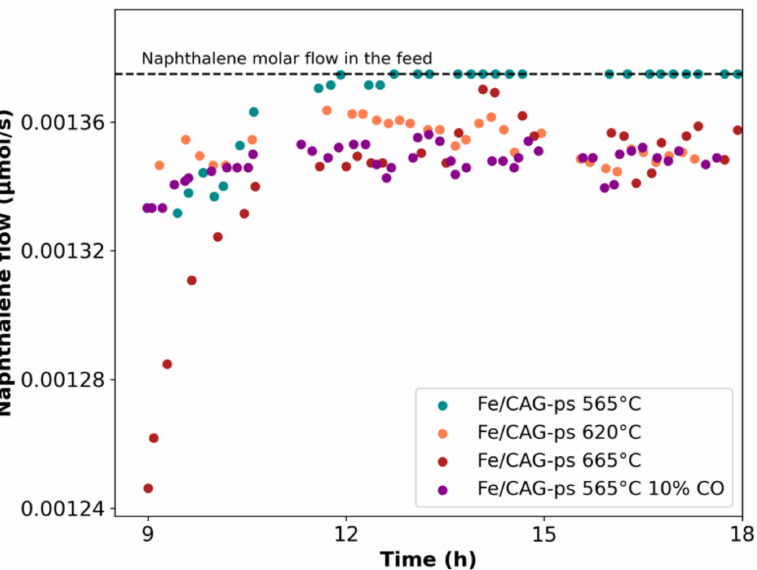
Figure 7. Naphthalene decomposition on Fe/CAG-ps at different temperatures and with co-fed CO at 565 ◦ C; both 960 mL/(min · g cat ) space velocity, 3130 ppmv of benzene, 660 ppmv of